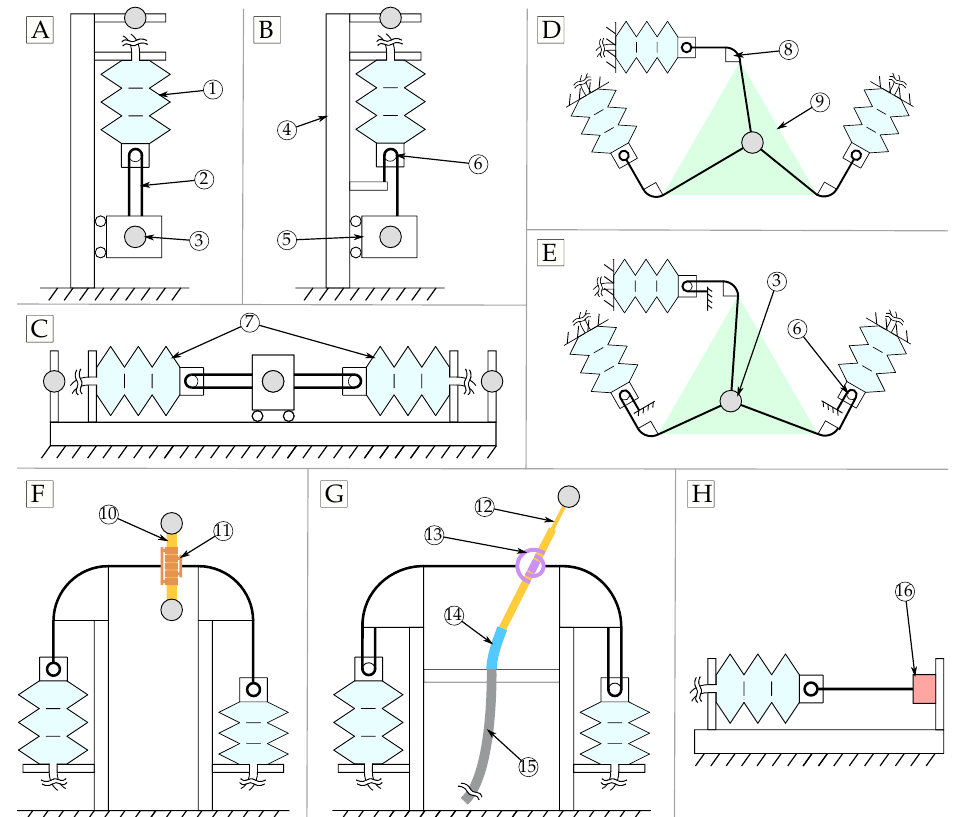
Figure 4. Diagrams of each of the test setups. ( A ) Single actuator. ( B ) Single actuator with pulley. ( C ) Two antagonistic actuators. ( D ) Planar parallel mechanism concept. ( E ) Planar parallel mechanism concept with pulleys. ( F ) Planar parallel mechanism setup with shaft coupling. ( G ) 3 DOF hybrid parallel mechanism with pulleys. ( H ) Force exertion setup. (1) Soft actuator. (2) Cables. (3) Retro- reflective marker. (4) Linear rail. (5) Linear stage. (6) Capstan on actuator. (7) Antagonistic actuators. (8) Entry point capstan. (9) Ideal workspace. (10) Shaft. (11) 2 DOF shaft coupling. (12) Telescopic shaft. (13) 3 DOF shaft coupling. (14) Rotary joint. (15) Bowden tube and flexible rod. (16) Force